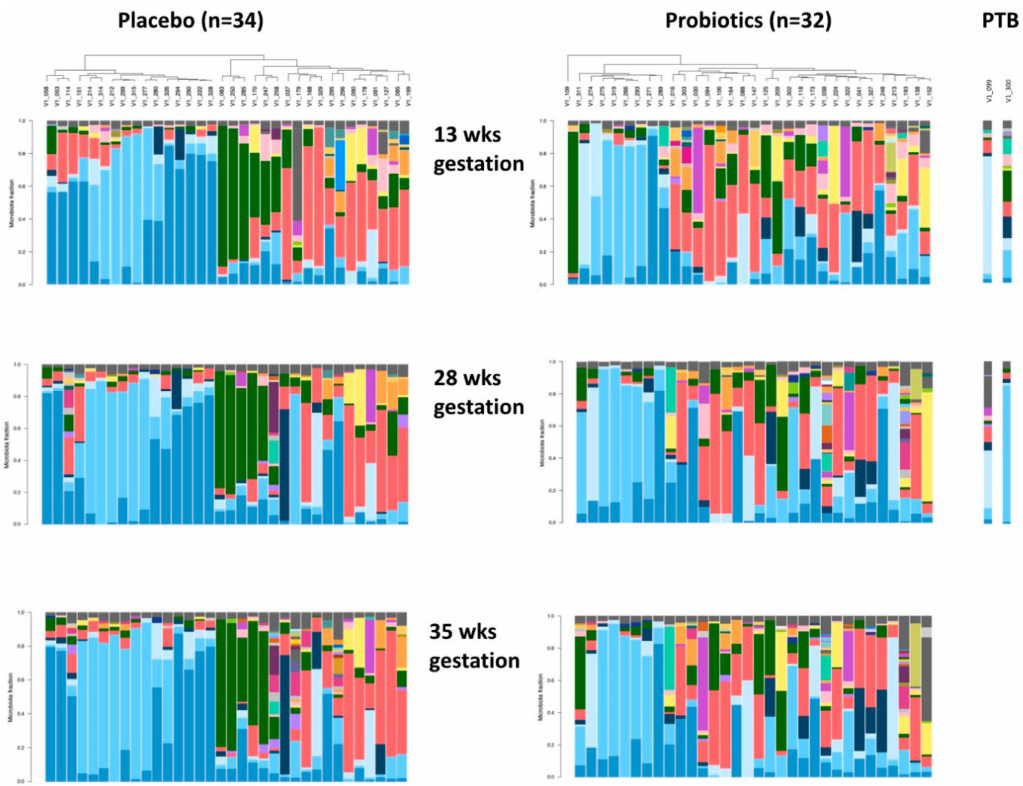
Figure 4. Vaginal microbiota across pregnancy clustered by bacteria similarity in pregnant women who received either placebo ( n = 34) or probiotic ( n = 32) treatment. Y Axis = Microbiota Fraction. Each bar represents the vaginal microbiota of a single woman and corresponds to the identification number labeled in the dendogram, clustered using average linkage cluster analysis. Species found in > 1% abundance are represented by a unique color and species that have < 1% abundance are pooled into a single fraction at the top of the bar in grey color. Women were aligned in the same vertical column at 13, 28 and 35 weeks of gestation. Women who have undergone preterm birth (PTB) ( n = 2) in the probiotic group are denoted with white squares. There was no e ff ect due to BV or Intermediate status.